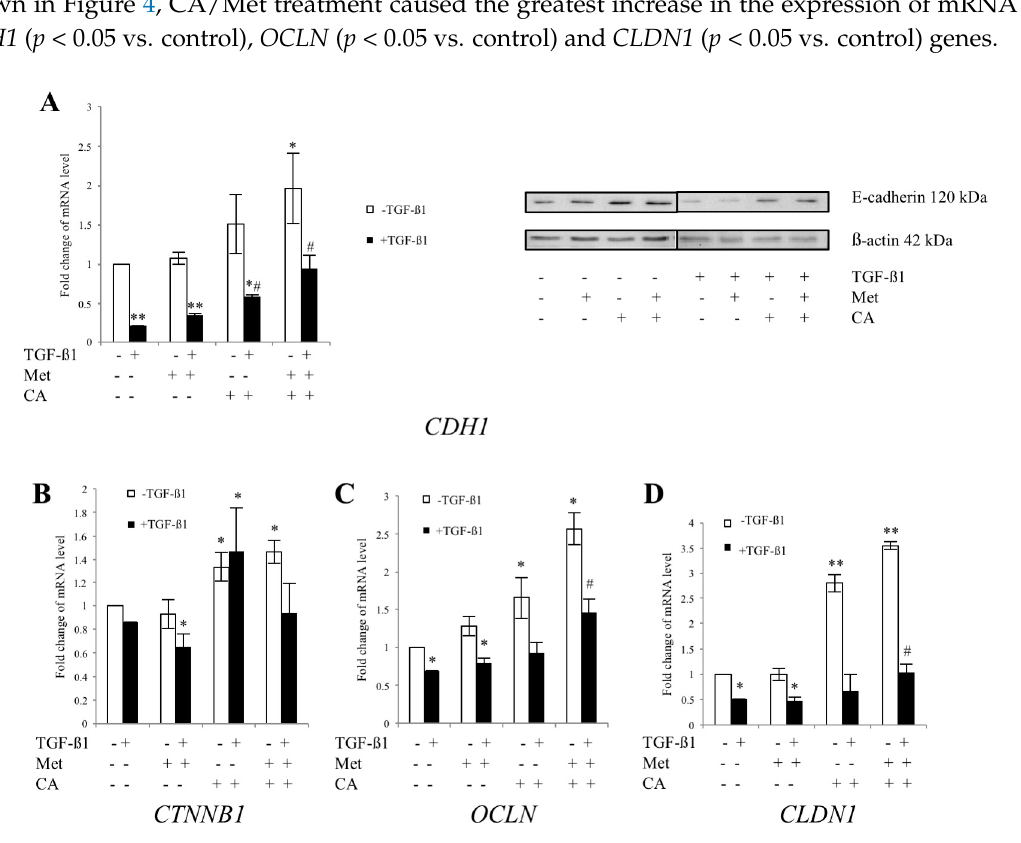
Figure 4. The effect of Caffeic Acid (CA) and Metformin (Met) on expression of epithelial markers in C4-I cells. The cells were treated for 48 h with TGF- β 1 (10 ng/mL) plus CA (100 μ M) and/or Met (10 mM). In parallel, cultures treated with tested compounds, but without TGF- β 1 were prepared. Analysis of mRNA level for E-cadherin ( CDH1 ), β -catenin ( CTNNB1 ), Occludin ( OCLN ) and Claudin ( CLDN1 ) was performed with Real-time PCR (( A ) left panel, ( B – D ), respectively). Protein levels of E-cadherin were analyzed by western blot and shown in the right panel of Figure 4A (20 μ g of total cell lysates were subjected to SDS-PAGE followed by immunoblotting and chemiluminescent detection, and β -actin was used as the protein loading control, the details described in Material and Methods). Note that the greatest upregulation for E-cadherin transcript was detected when CA was applied with Met (( A ), left panel); the same effect was found for Occludin ( C ) and Claudin ( D ) (* p < 0.05 vs. control for E-cadherin, * p < 0.05 vs. control for Occludin, * p < 0.01 vs. control for Claudin). For qPCR the data were normalized against GAPDH transcript as a reference gene and levels of RNA expression were determined with the 2 − ∆∆ C t method (* p < 0.05 and ** p < 0.01 vs. control, # p < 0.05 vs control with TGF- β 1). Experiments were repeated three times with similar results and presented as mean values ±